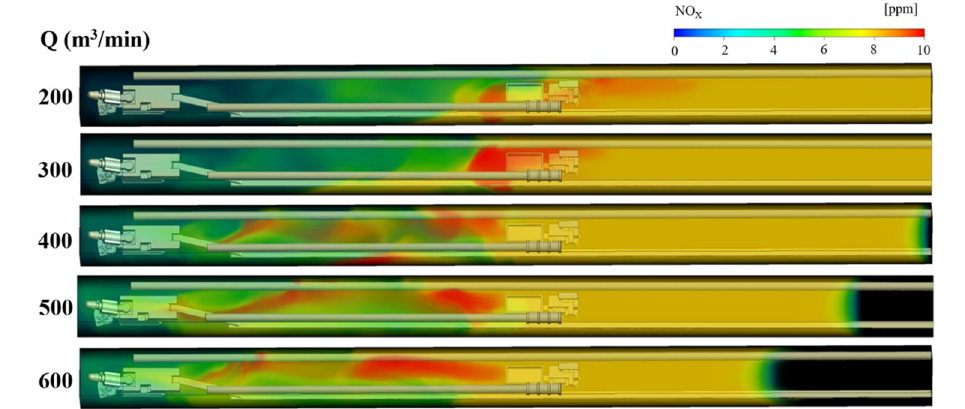
Figure 8. NO x gas distribution under different air volumes Q at L = 40 m.